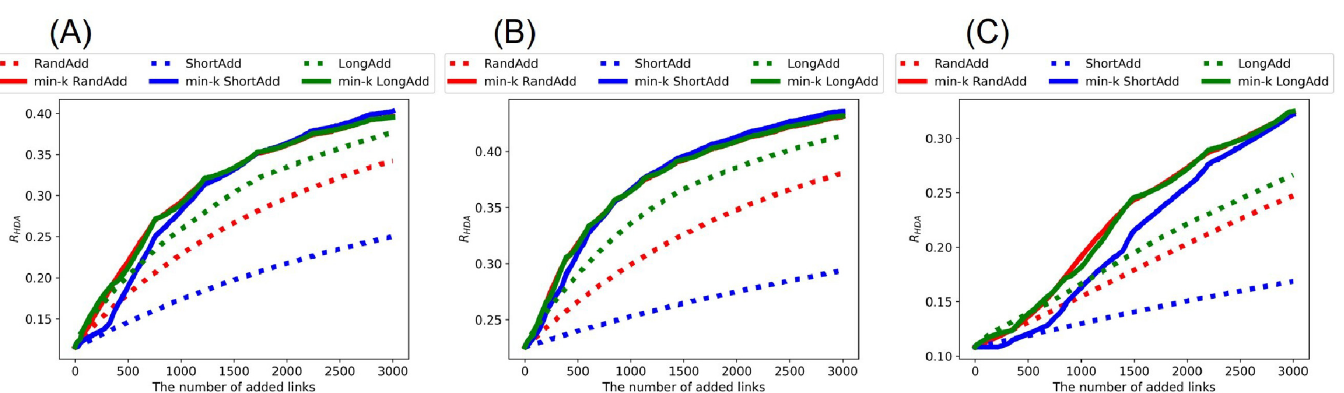
Fig 9. Robustness index against typical HDA attacks after adding links to real networks. The min- k RandAdd, min- k LongAdd, and min- k ShortAdd methods (red, green, and blue solid lines) are the most effective for improving R HDA . The initial networks are (A) AirTraffic, (B) Email, and (C) Yeast. The correspondence between lines and methods is the same as shown in Fig 2.